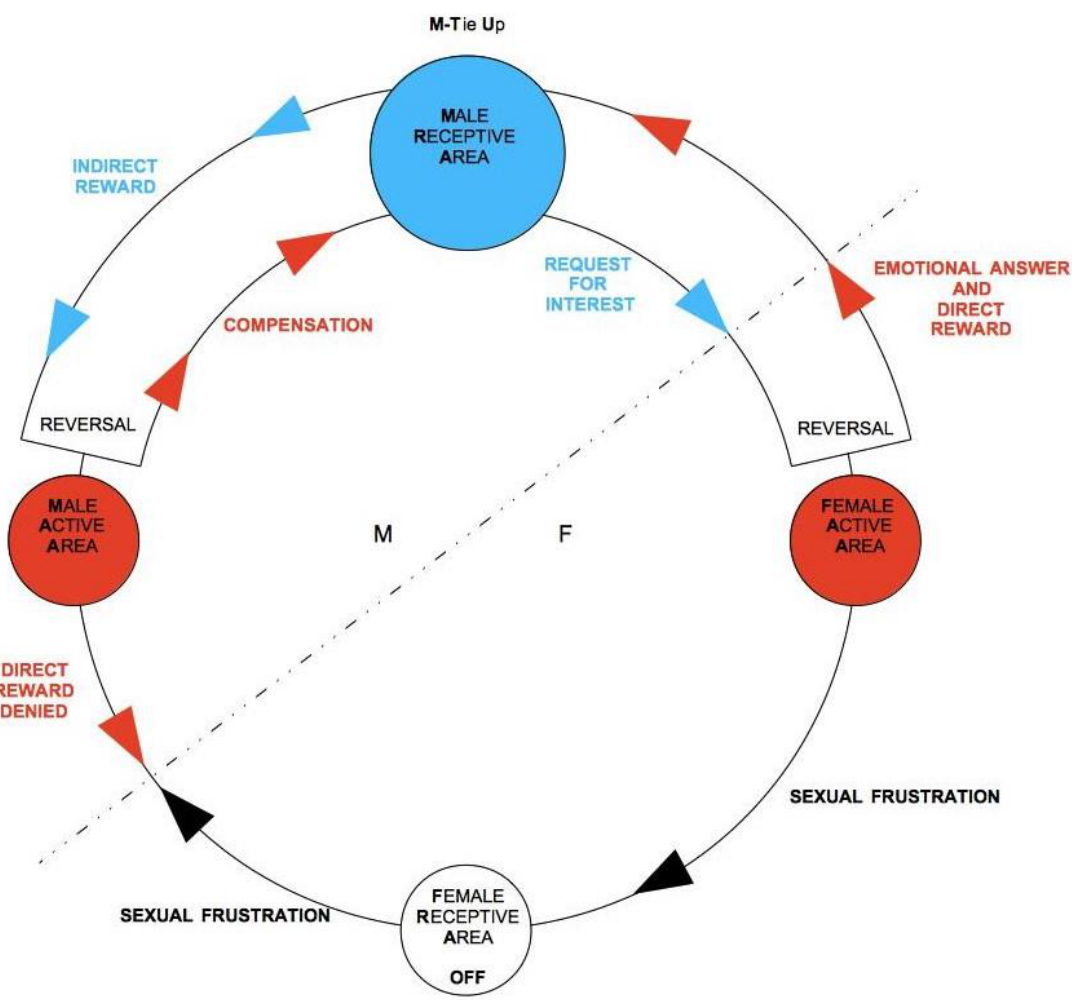
Figure 8. F-driven inversion of TU-C; frustration of M’s direct reward.